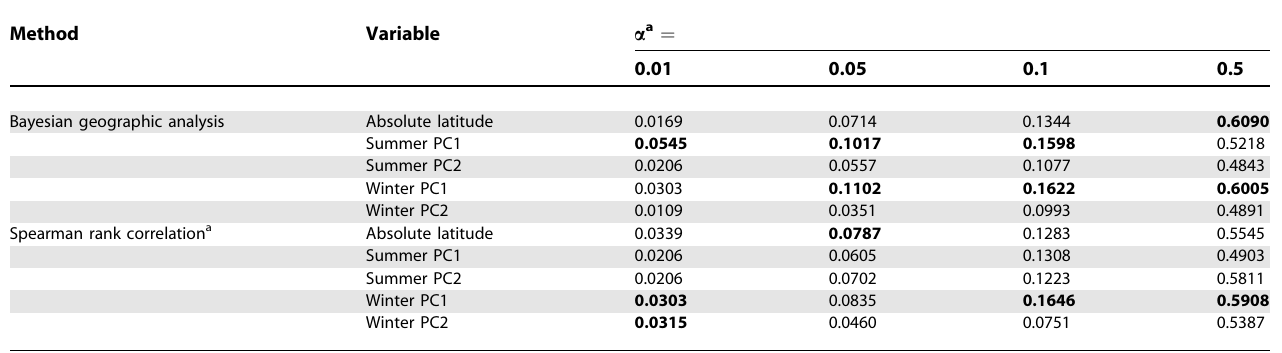
Table 1. Proportion of SNPs Significant with Climate Variables Using a Parametric (Bayesian Geographic Analysis) and a Nonparametric (Spearman Rank Correlation) Method